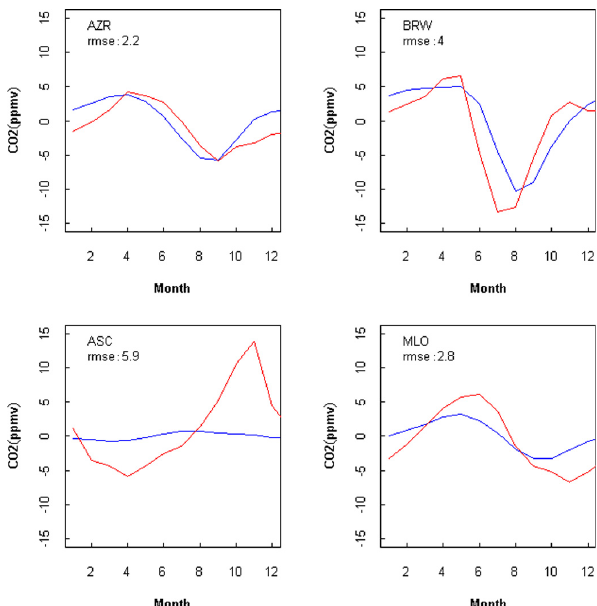
Fig. 5. Modelled (red) and observed (blue) seasonal variation of atmospheric carbon dioxide at four stations: Azores (AZR), Barrow (BRW), Ascension (ASC), and Mauna Loa